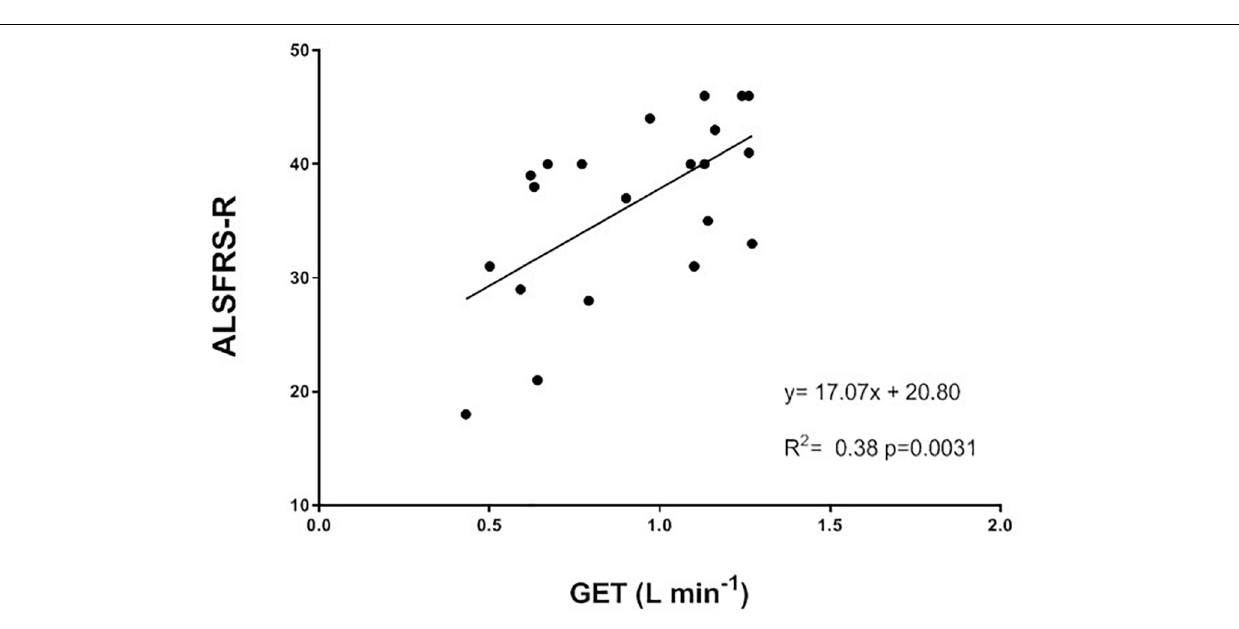
FIGURE 7 | Correlation between gas exchange threshold (GET) and the ALS functional rating scale revised (ALSFRS-R) for all the participants in this study (TRAIN and UC